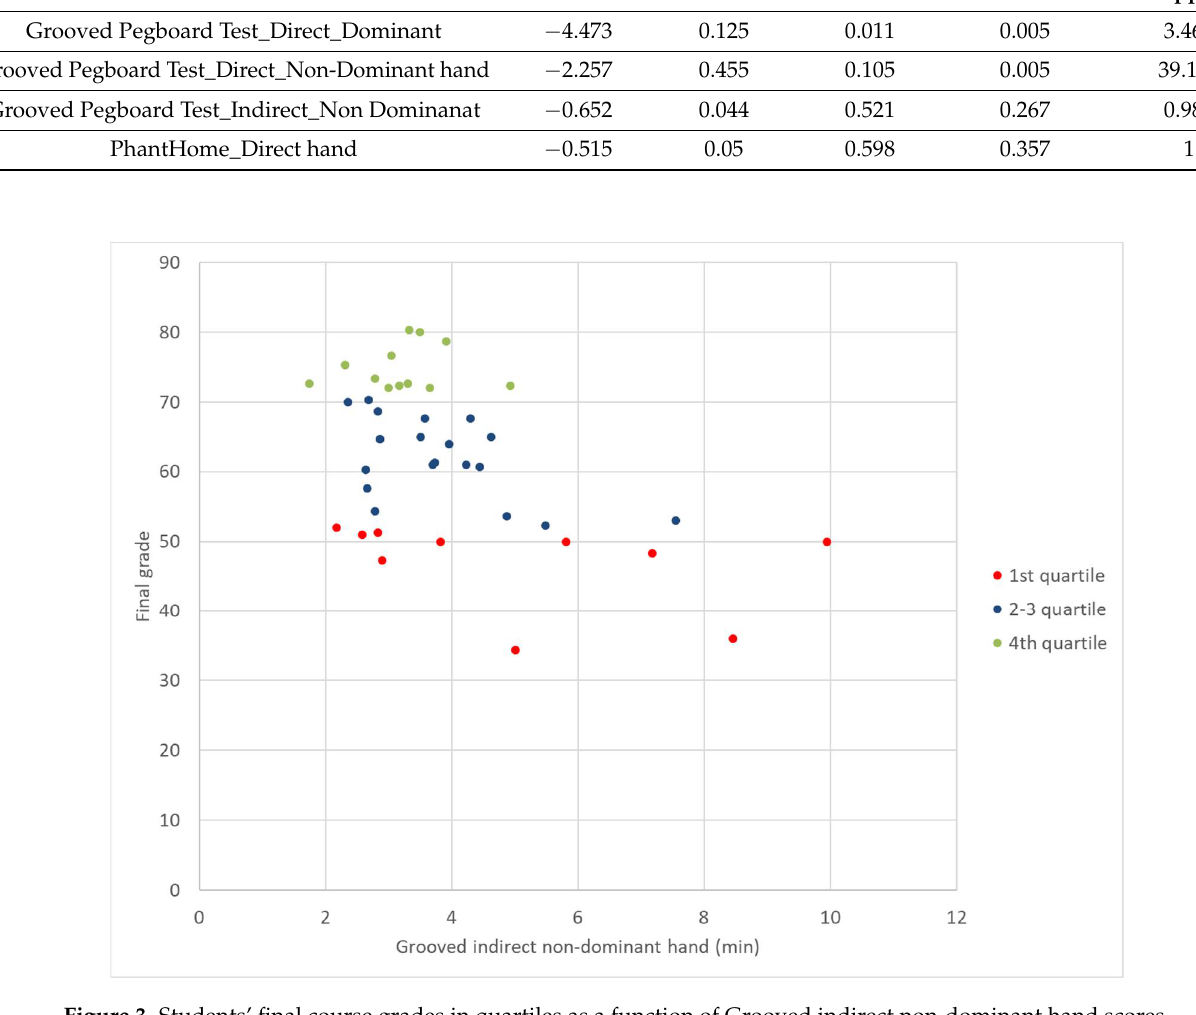
Figure 3. Students’ final course grades in quartiles as a function of Grooved indirect non-dominant hand scores.